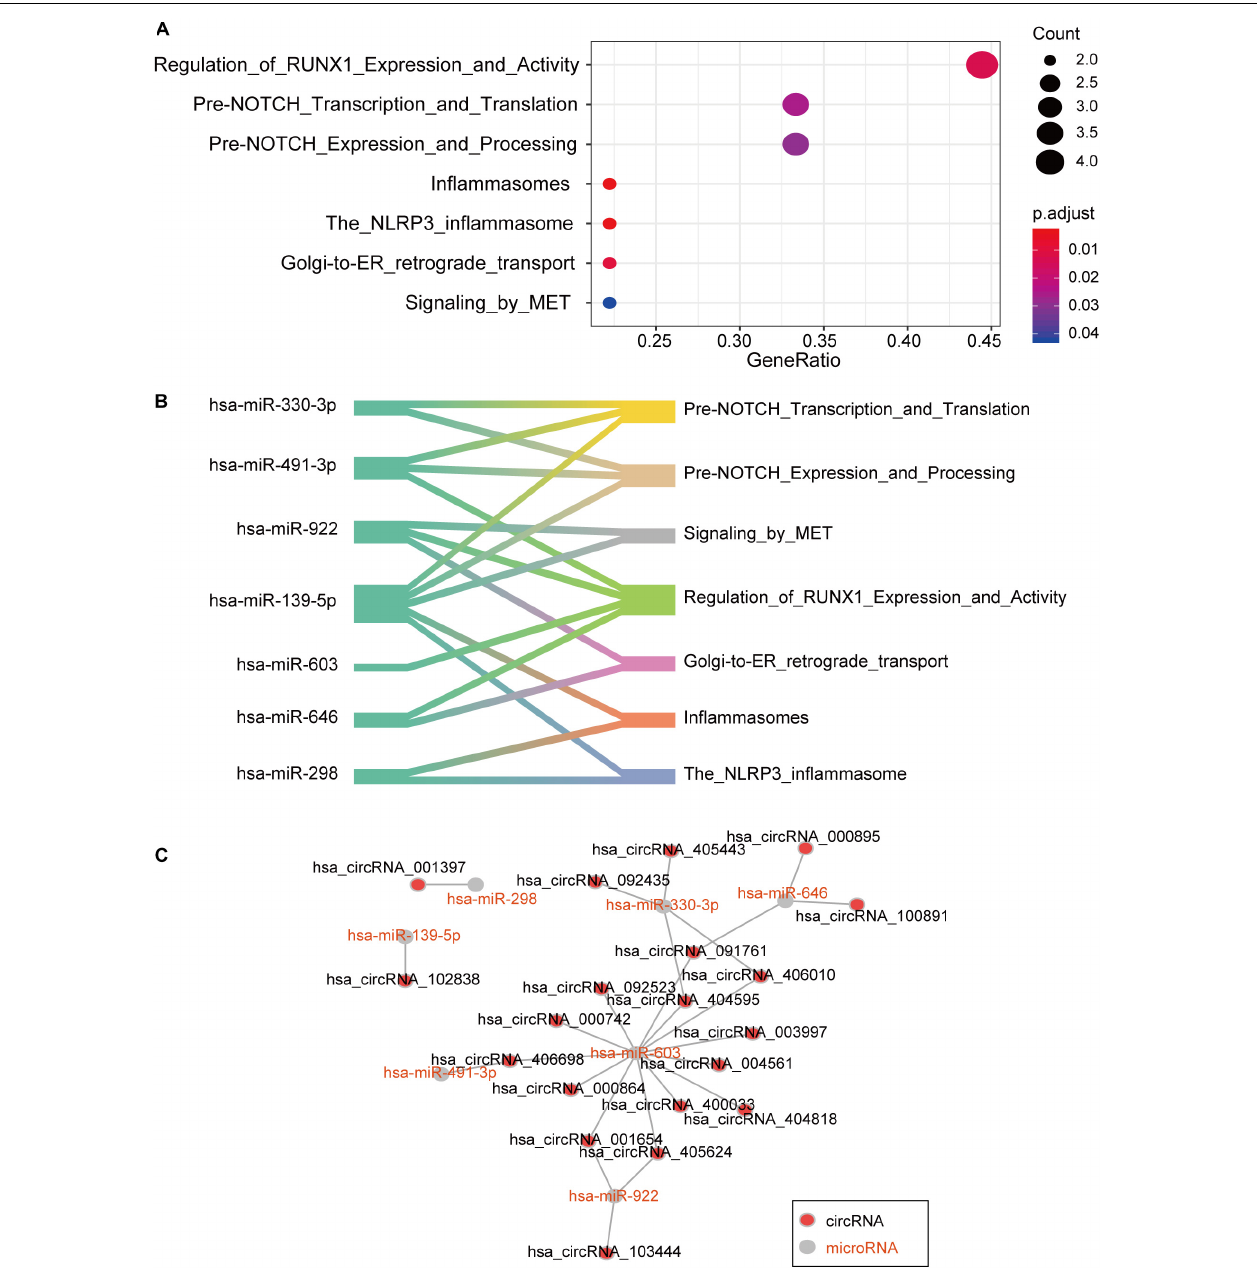
FIGURE 3 | CircRNA-miRNA interaction networks of seven candidate miRNAs. (A) Signaling pathways enriched by the miRNAs interacting with circRNAs. (B) Networks between miRNAs and signaling pathways. (C) Interaction of seven candidate miRNAs with circRNAs.